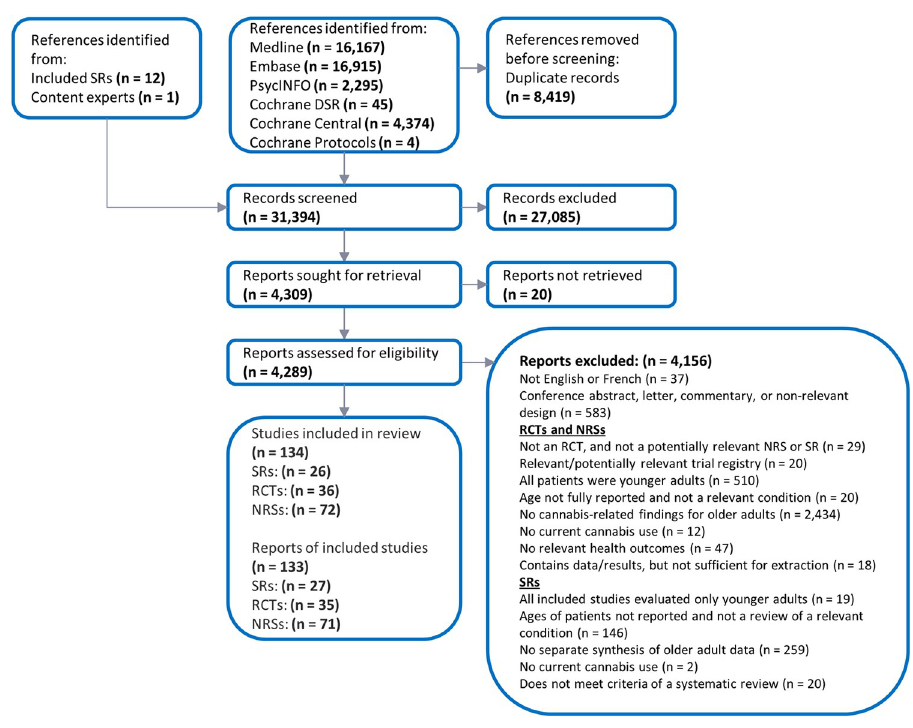
Fig 1. Overview of publication selection